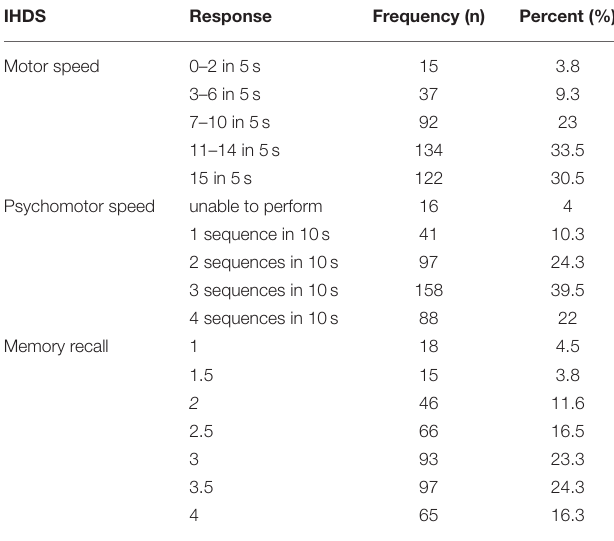
TABLE 3 | The International HIV Dementia Scale (IHDS) Distribution of PLHA at government health institution in Bahir Dar,